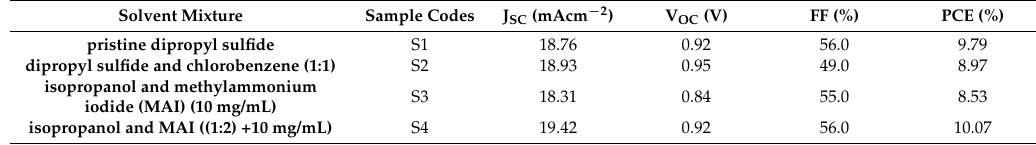
Table 1. The photovoltaic parameters of the PSCs fabricated with different solvent ration.